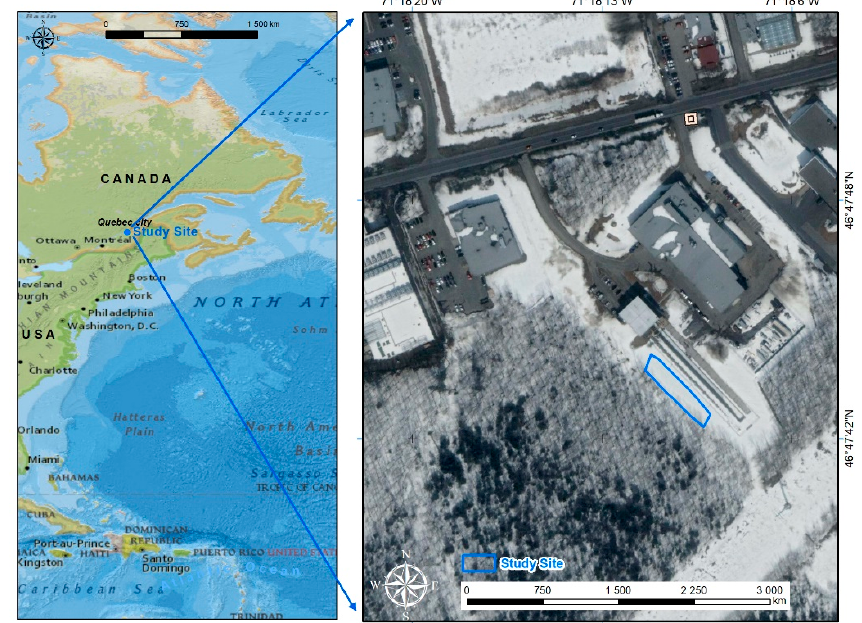
Figure 1. Geographical location of the sampling area.